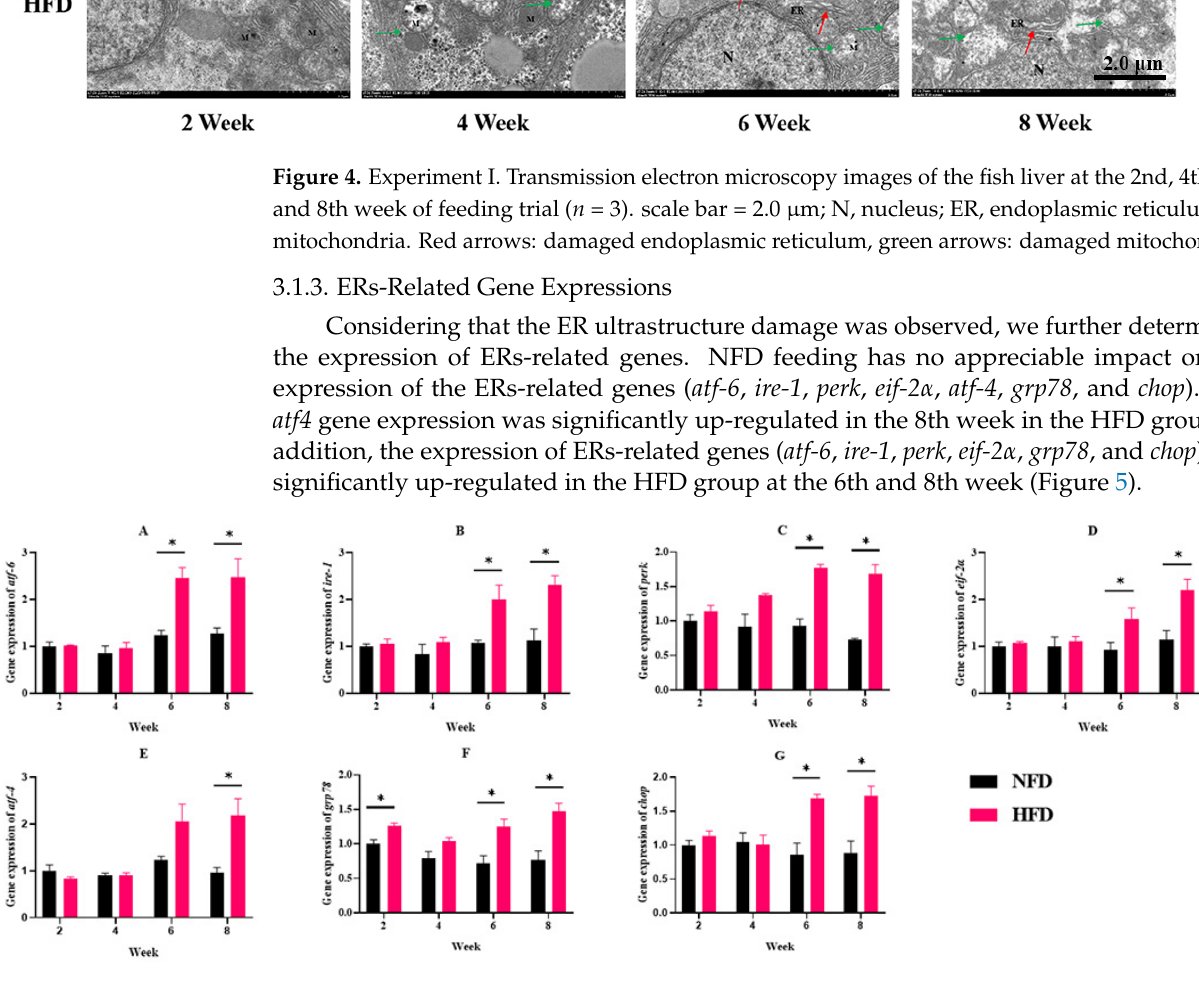
Figure 5. Experiment I. The expressions of endoplasmic reticulum stress-related genes in the liver. ( A ) Gene expression of atf6 . ( B ) Gene expression of ire-1 . ( C ) Gene expression of perk . ( D ) Gene expression of eif-2 α . ( E ) Gene expression of atf4 . ( F ) Gene expression of grp78 . ( G ) Gene expression of chop . “*” indicates a significant difference between groups ( p < 0.05, Student’s t -test, n = 3).